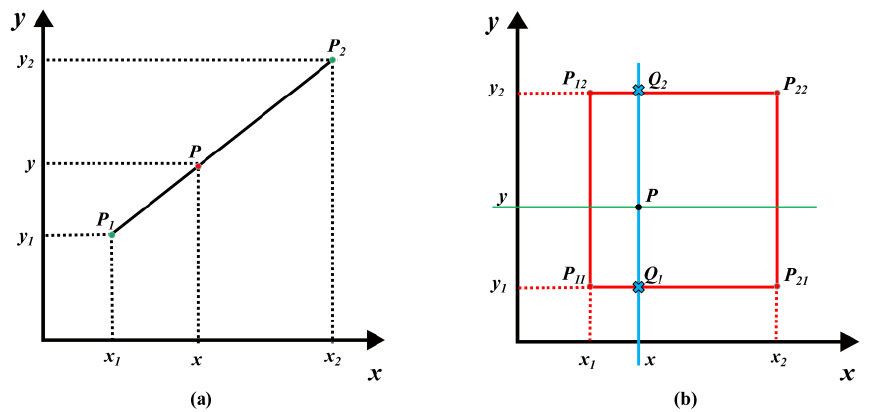
Figure 2. A diagram of the linear interpolation: ( a ) single-linear interpolation; ( b ) bilinear interpola- tion.